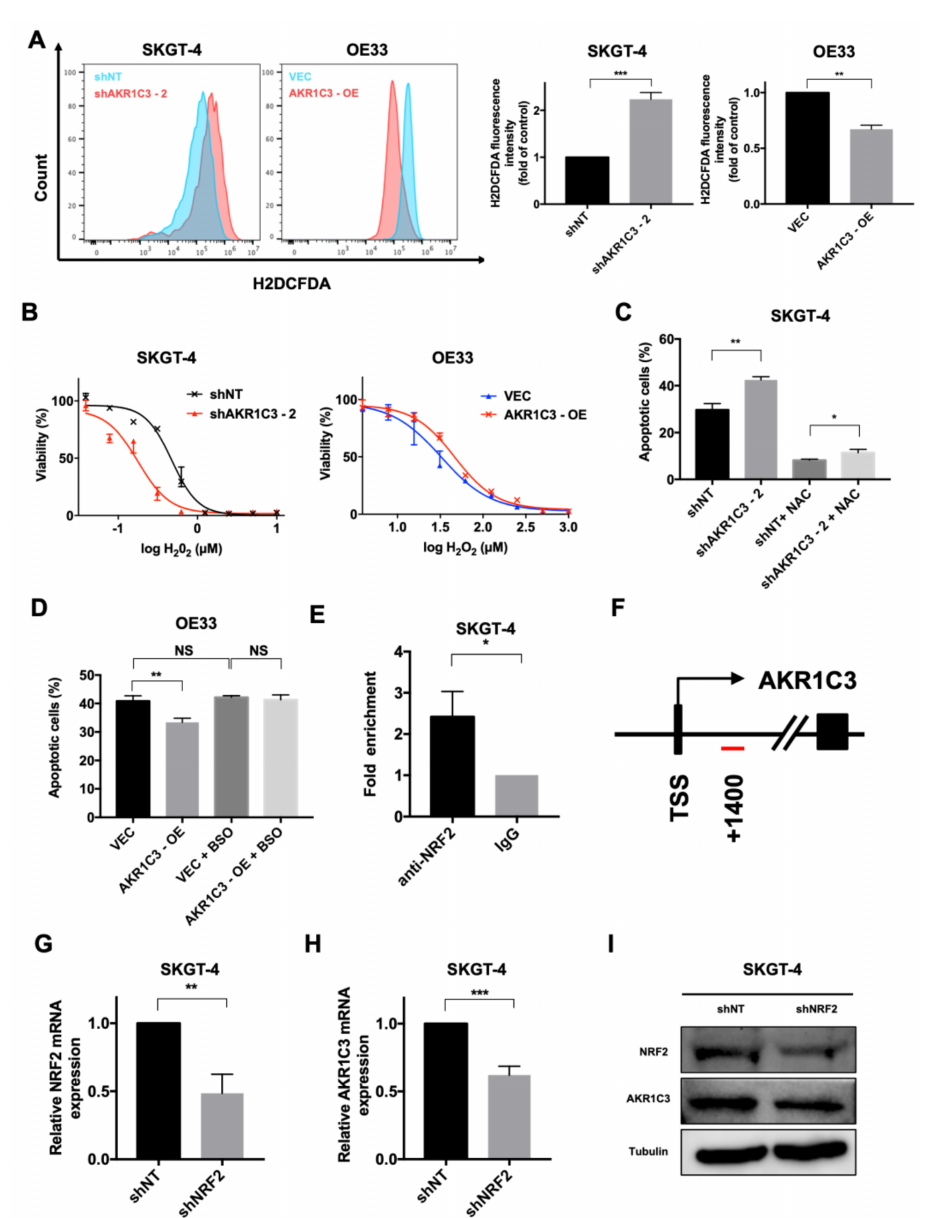
Figure 4. AKR1C3 mediates chemo-resistance through regulating redox homeostasis. ( A ) Intracellular ROS production was measured by flow cytometry using H2DCFDA. Representative FACS histograms are shown on the left. Bar graphs are shown on the right panel. Data are presented as mean ± SD of three independent experiments. ( B ) Cell viability assay was used to determine cell viability after hydrogen peroxide treatment for 24 h in SKGT-4 and OE33 cells. ( C ) SKGT-4 cells were incubated with 4 mM NAC and 10 µ M cisplatin for 48 h, followed by the measurement of apoptosis (annexin V/DAPI flow cytometry, bar charts). ( D ) OE33 cells were incubated with 50 µ M BSO and 10 µ M cisplatin for 48 h, followed by measurement of apoptosis (annexin V/DAPI flow cytometry, bar charts). ( E , F ) Chromatin immunoprecipitation assay indicates direct binding of NRF2 to the promoter region of AKR1C3 (around transcription start site (TSS) +1400, indicated by a red bar). ( G – I ) NRF2 mRNA levels and protein levels were analyzed after NRF2 knockdown in SKGT-4 cells. * p < 0.05, ** p < 0.01, *** p < 0.001, NS: non-significant ( p >